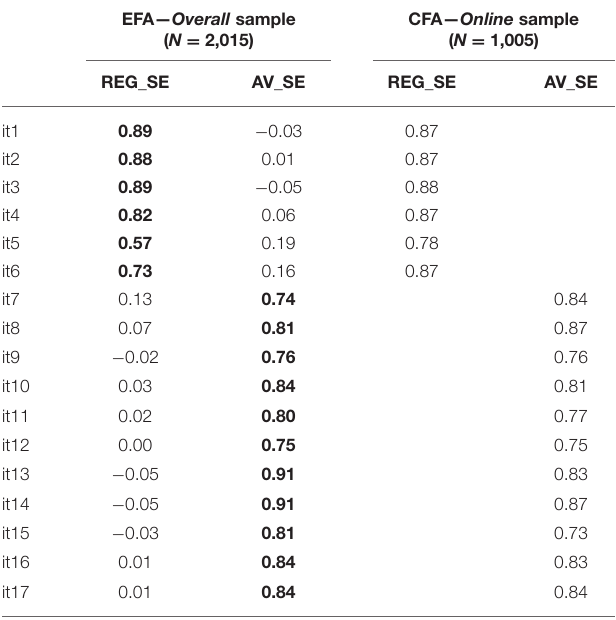
TABLE 2 | Standardized factor loadings on both samples for the final two-factor EFA solution and from the CFA model. EFA— Overall